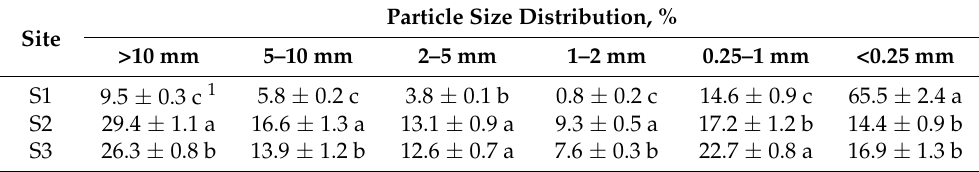
Table 3. Granulometric composition of substrates from studied